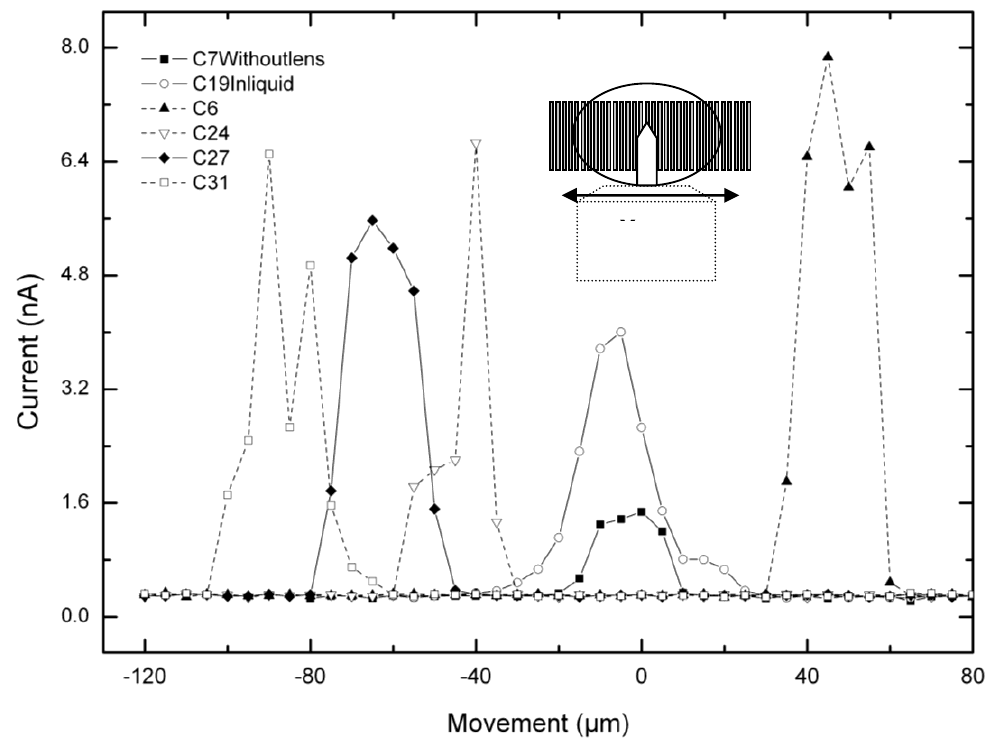
Figure 4. Sketch of the micro cantilever moving sideways, after having entered parallel to the sensor lines as in Figure